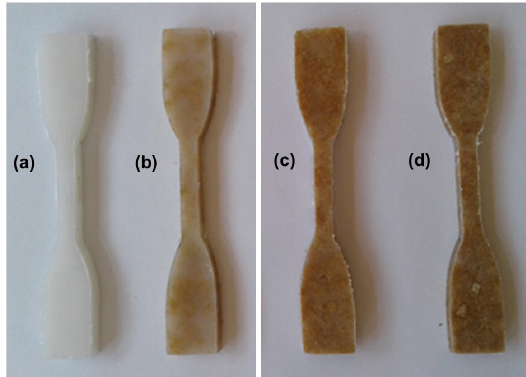
Figure 1. Composites containing babassu fiber and low-density polyethylene (a) LDPE 100% (b) LDPE 95% (c) LDPE 90% and (d) LDPE 80%.